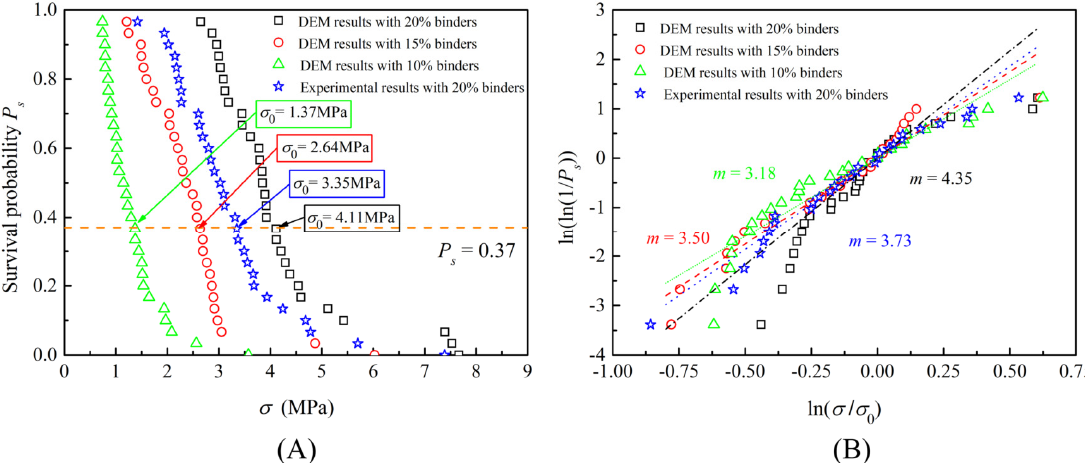
Figure 13. Statistical results of particle-crushing strengths from the DEM and experimental studies: ( A ) particle survival probability distribution; ( B ) Weibull